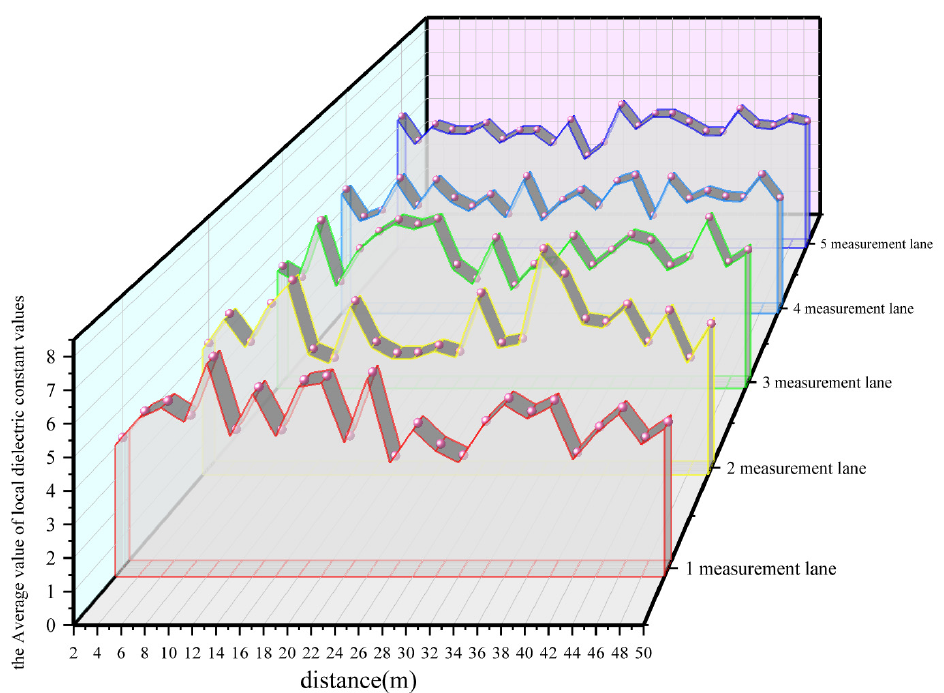
Figure 13. Distribution of the average values of the local dielectric constants in asphalt pavements.